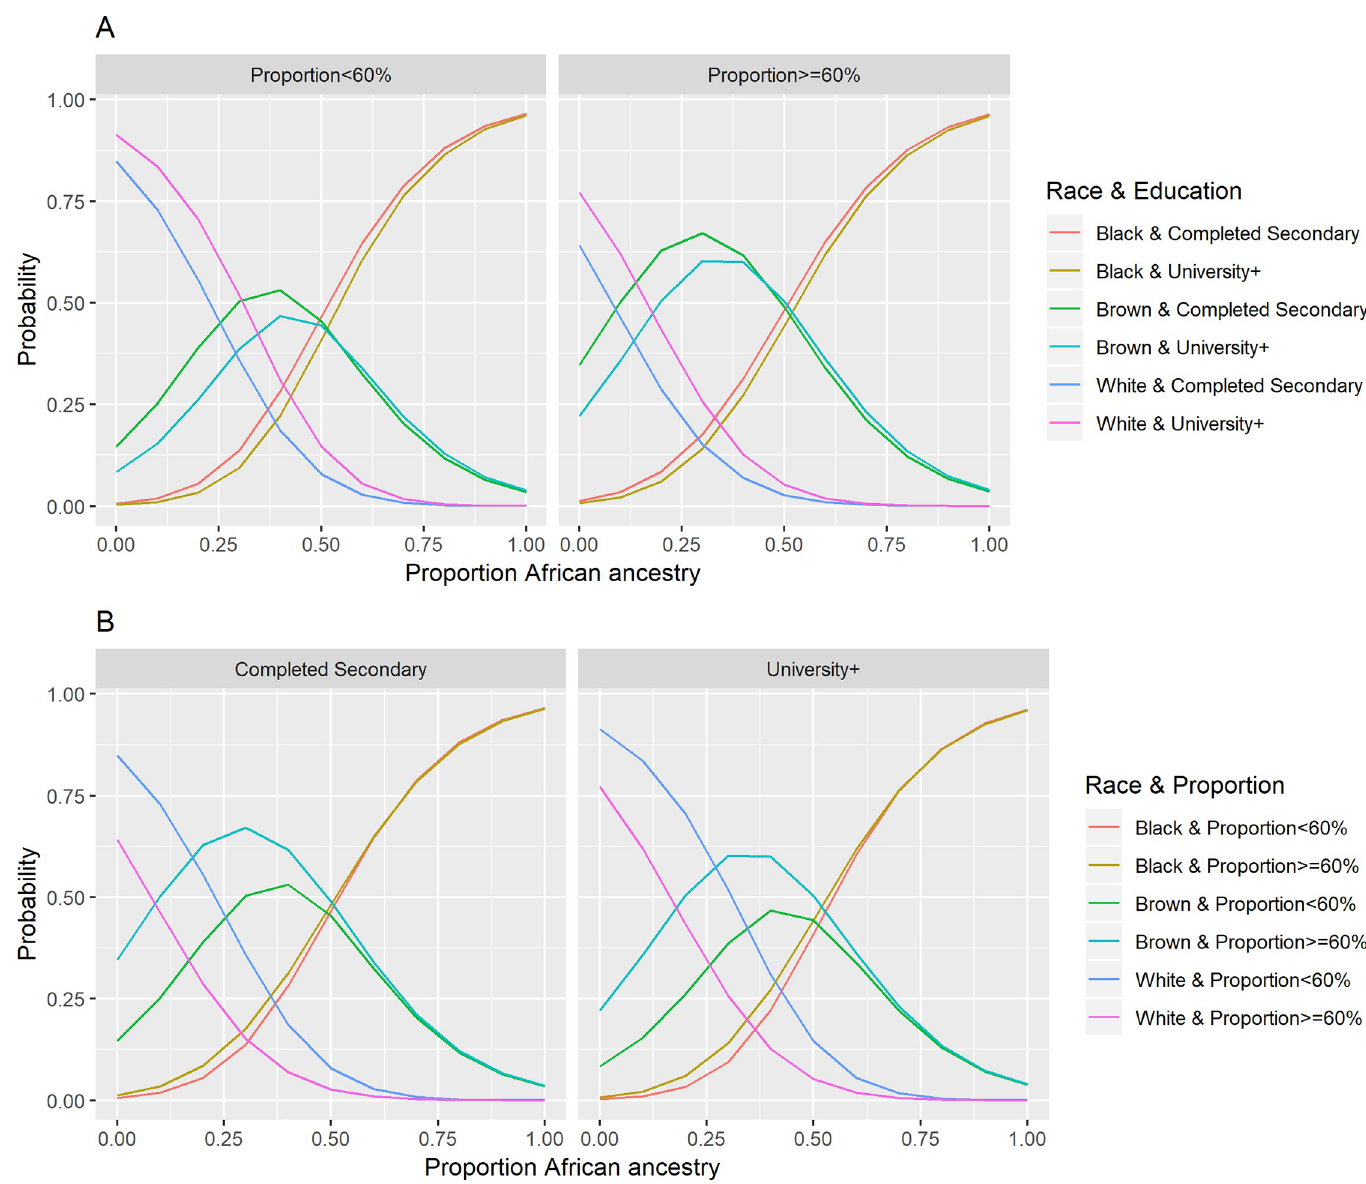
Fig 3. Predicted probability of ethnoracial self-classification as black, brown and white along the continuum of genomic proportion of African ancestry in all participants, and by (A) educational level and proportion of black and brown inhabitants ( � 60% or < 60%) in the census tracts of residence (ELSA-Brasil) and (B) by proportion of black and brown inhabitants ( � 60% or < 60%) in the census tracts of residence and by educational level (ELSA-Brasil).